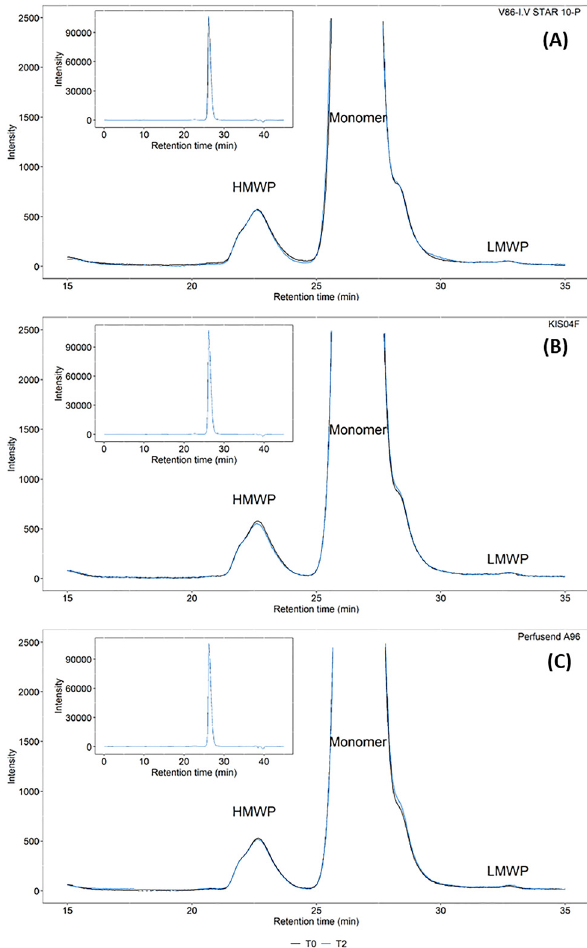
Figure 2: Evolution of infliximab concentrations (mean ± 95% con fi dence interval, n=3) quanti fi ed by size exclusion chromatography at 0.4 mg/mL (A) and 2 mg/mL (B) during 2 h of simulated infusion (dynamic condition).